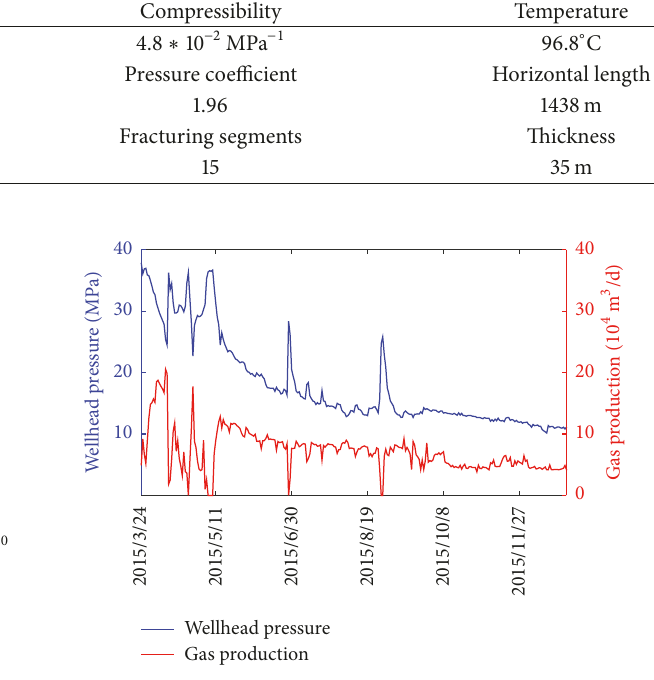
Figure 15: Production